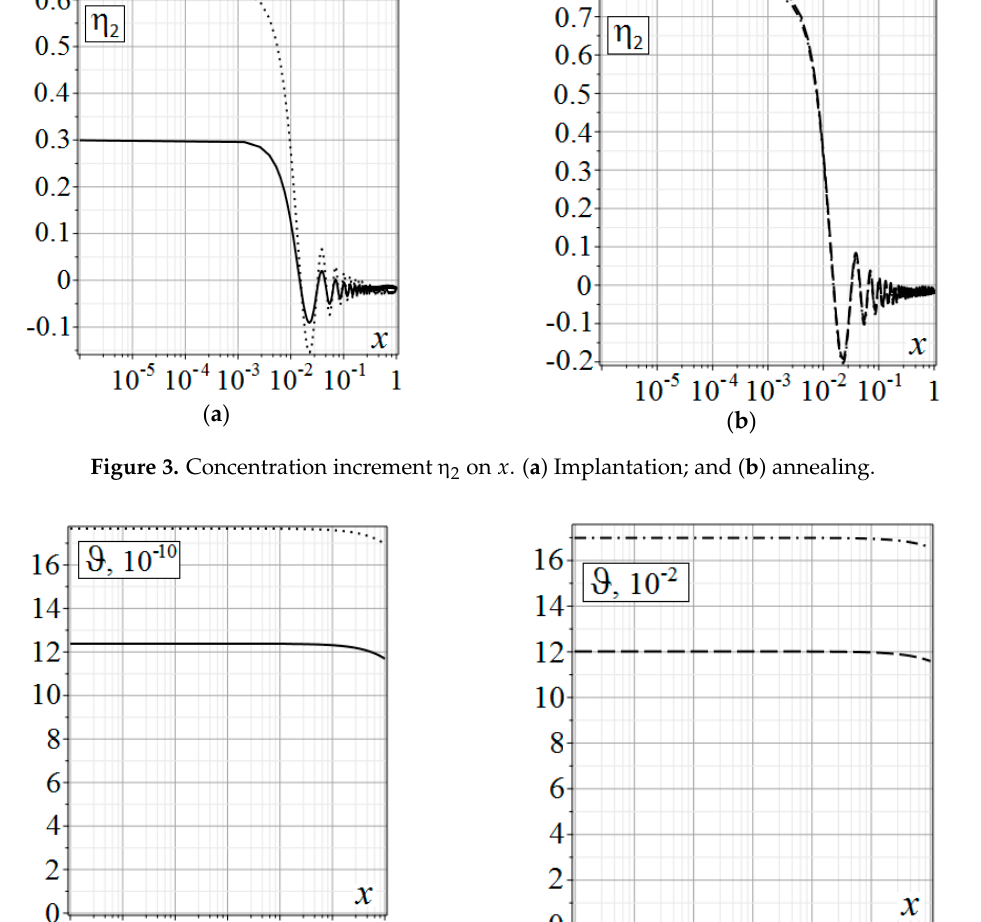
Figure 2. Concentration increment